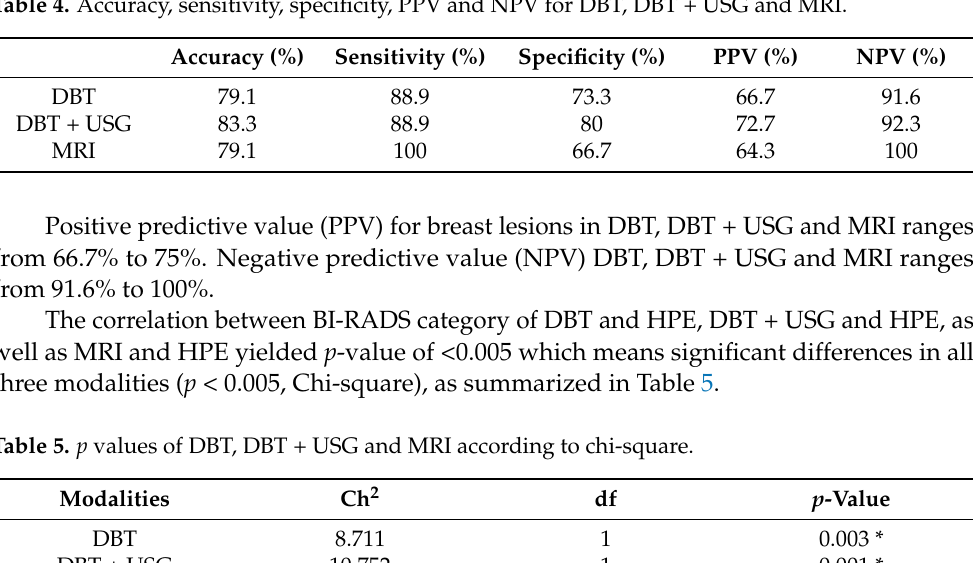
Table 5. p values of DBT, DBT + USG and MRI according to chi-square. Modalities Ch 2 df p -Value DBT 8.711